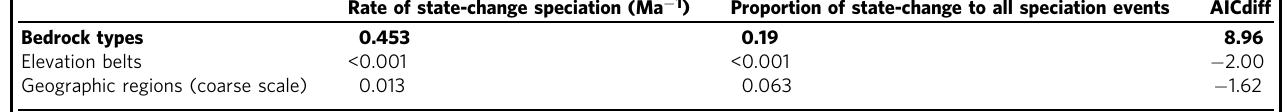
Values with AICdiff>2 are depicted in